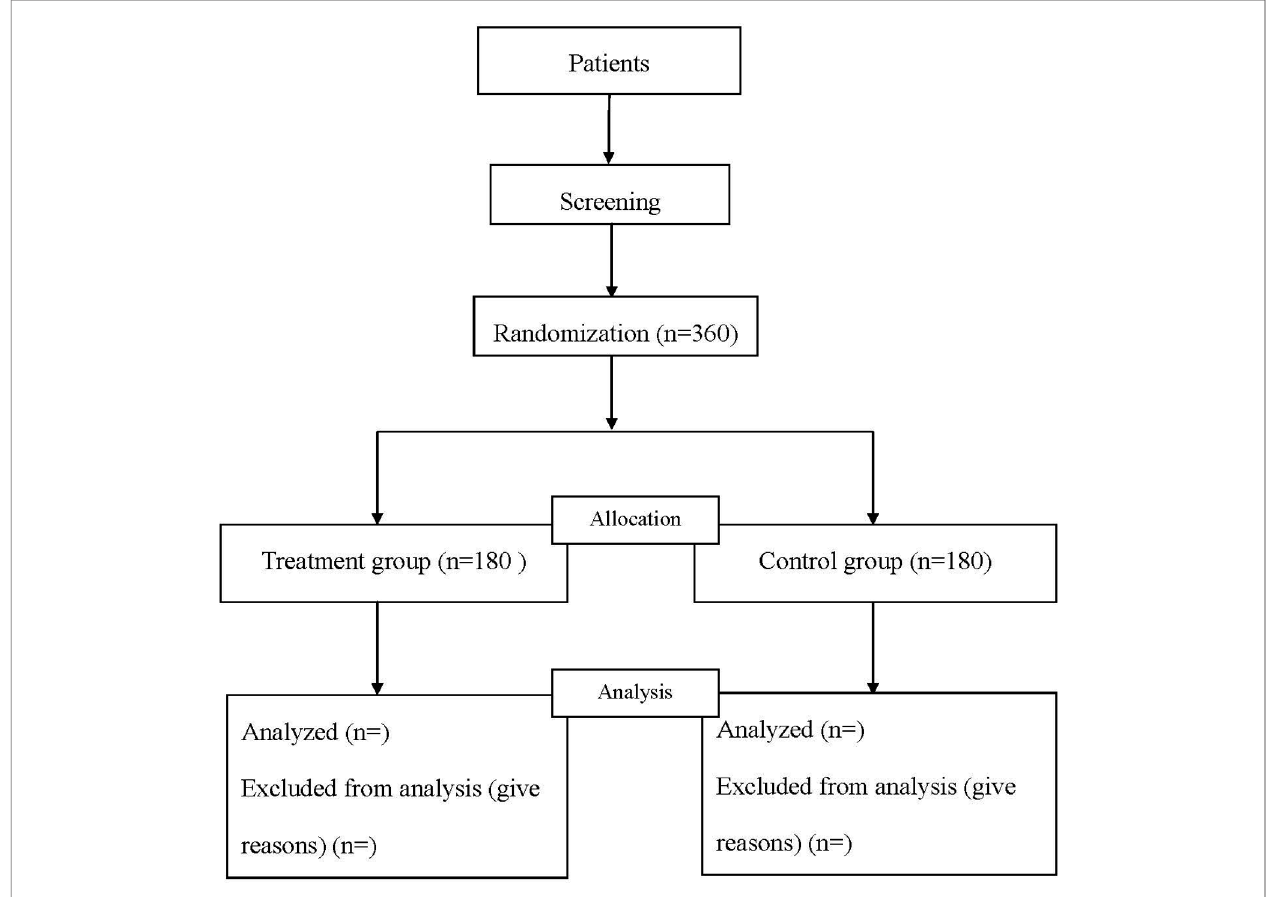
FIGURE 1 | Flow diagram of the